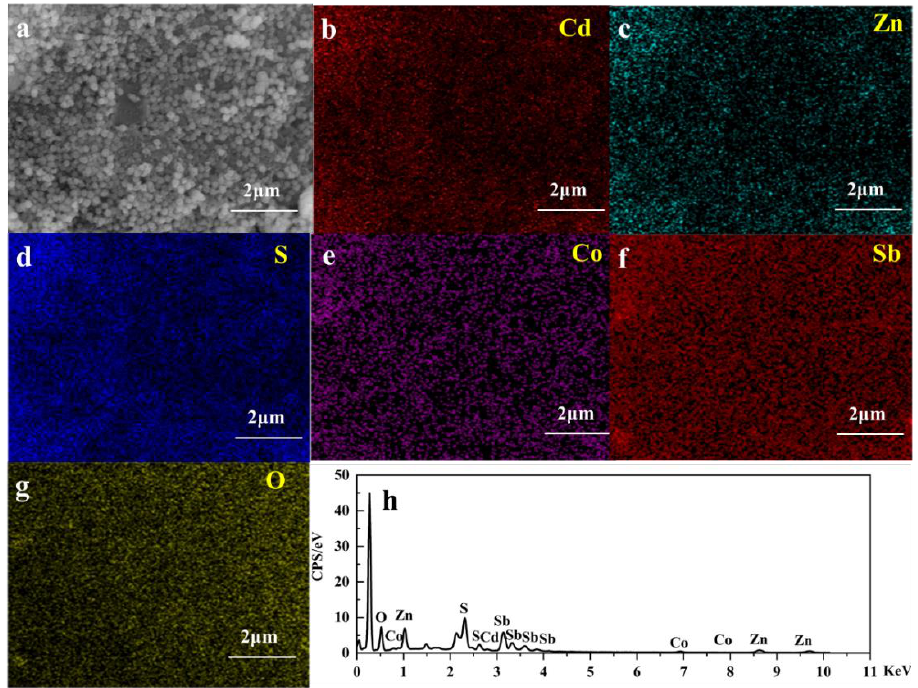
Figure 5. The EDS mapping results of ZCS@1CSO, the analysis area ( a ), Cd ( b ), Zn ( c ), S ( d ), Co ( e ), Sb ( f ), O ( g ), the total element EDX analysis of analysis area ( h ).